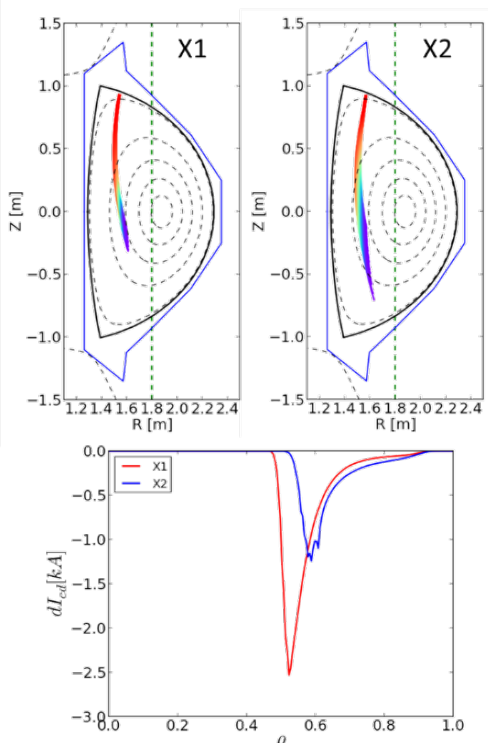
Fig. 8. The ray trajectories of 105 GHz fundamental harmonic X-wave and 170 GHz second harmonic X-wave, and the current drive profile of each